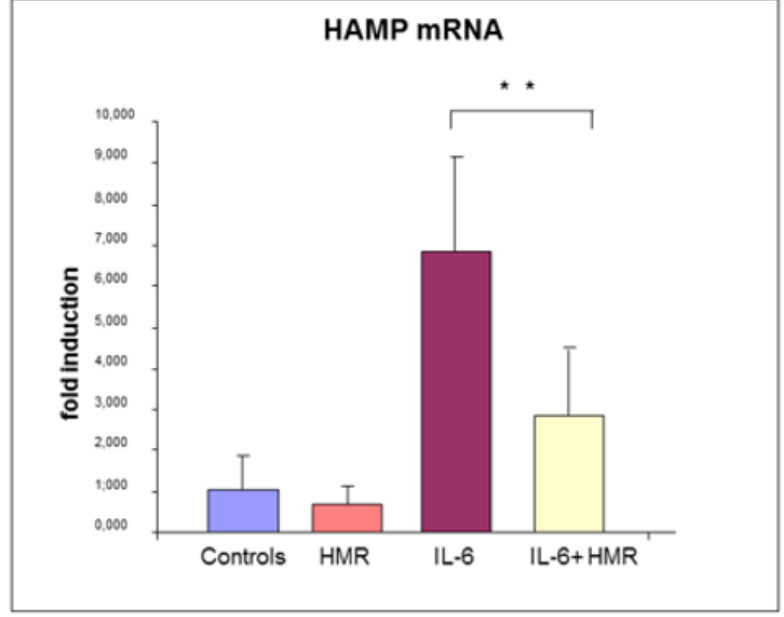
Figure 3. Caco-2 cells were treated with 50ng/mL IL-6, in the presence or absence of 1μM HMR. Hepcidin mRNA expression was measured as fold induction by real time RT-PCR, compared to untreated cells. The results, are expressed as mean ± SD of three experiments [102]. ** p value <